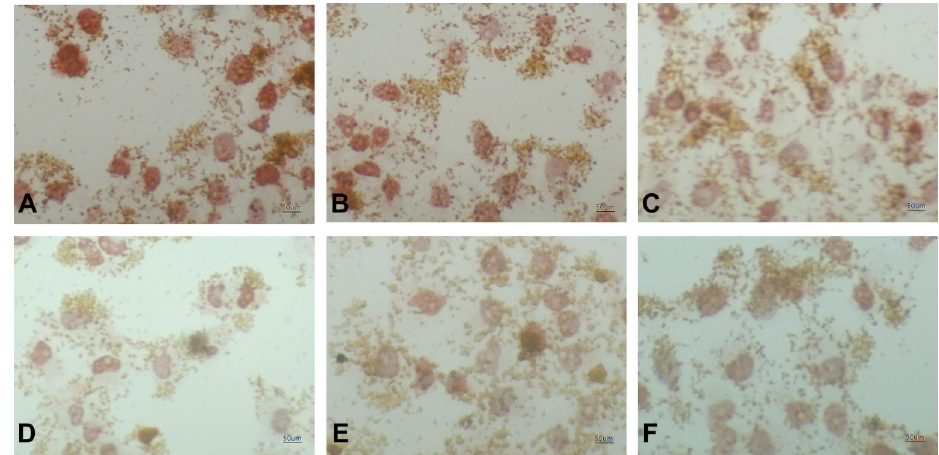
Figure 10. Immunocytochemical images (200 6 ) of p53 expression in SMMC-7721 hepatoma cells. A , Control group A (RPMI 1640 culture medium only); B , spiking group (8 g/L Fe 2 O 3 , no radiation); C , 2 g/L Fe 2 O 3 MFH group; D , 4 g/L Fe 2 O 3 MFH group; E , 6 g/L Fe 2 O 3 MFH group; F , 8 g/L Fe 2 O 3 MFH group. MFH: magnetic fluid